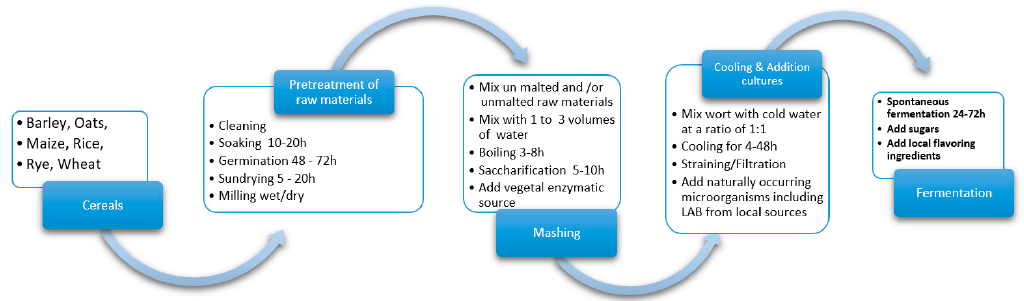
Figure 1. General flow diagram of traditional NFCB production.